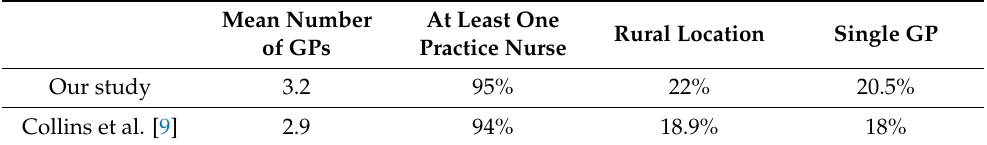
Table 2. Study data ( n = 125) compared to Collins et al. [9]. ( n = 507).